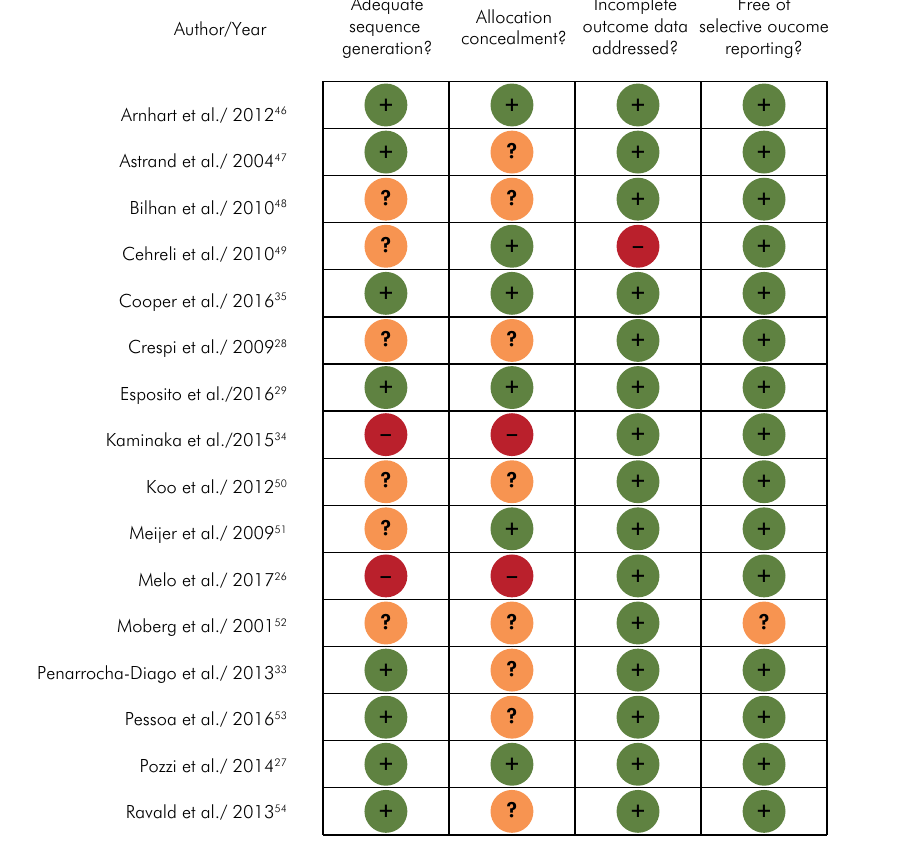
Figure 2. Summary of the risk of bias assessment according to the Cochrane Collaboration tool.